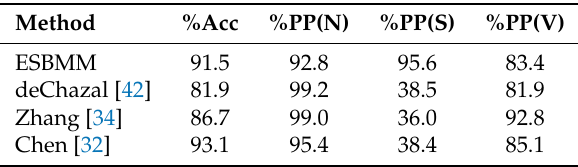
Table 6. Beat classification performances over the